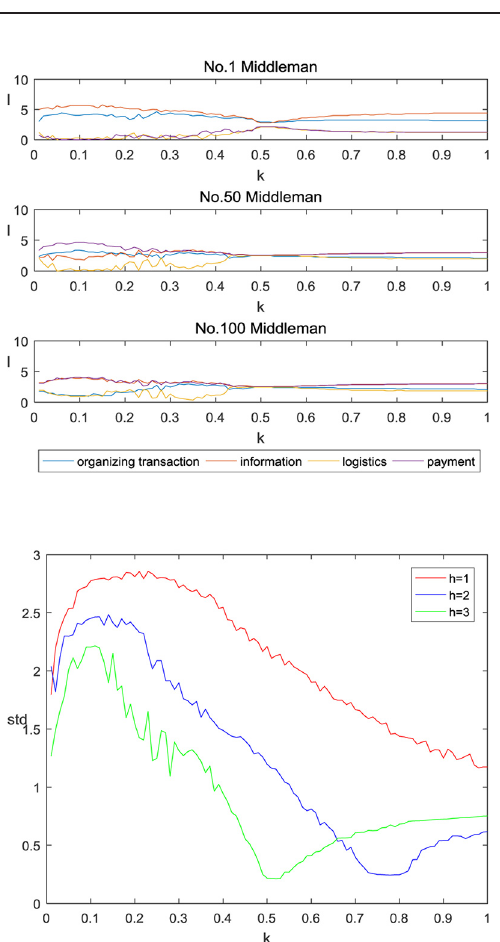
Figure 9. Uncorrected sample standard